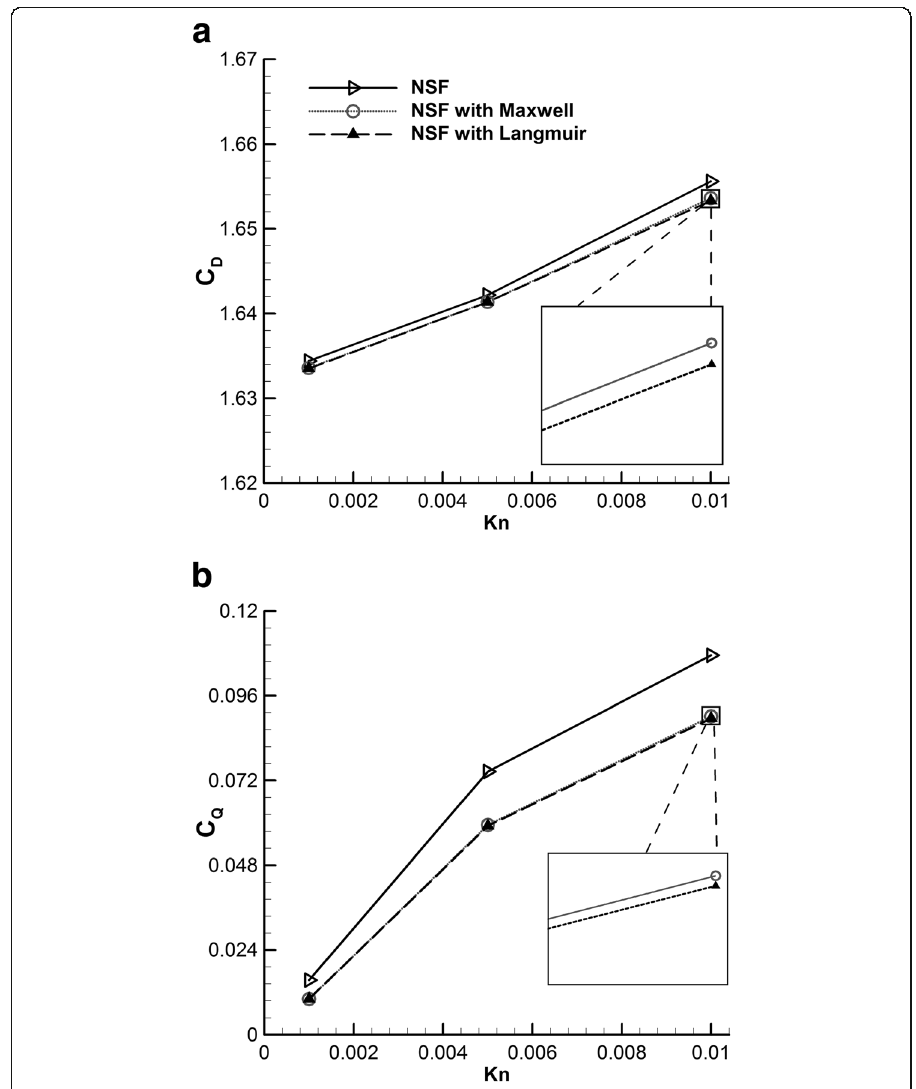
Fig. 11 Comparison of the aerothermodynamic coefficients for varying Knudsen numbers (0.001, 0.005, and 0.01) at M = 6: a drag coefficient, and b heat flux